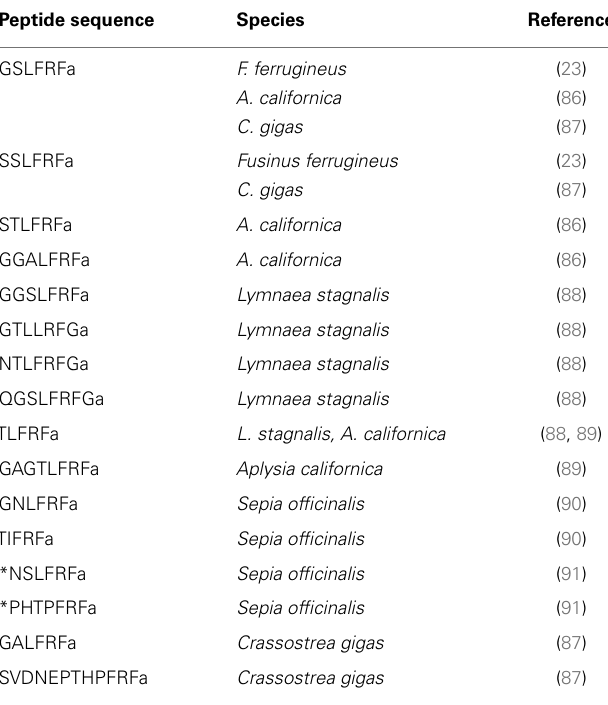
Table 3 | LFRFamide-related peptides .